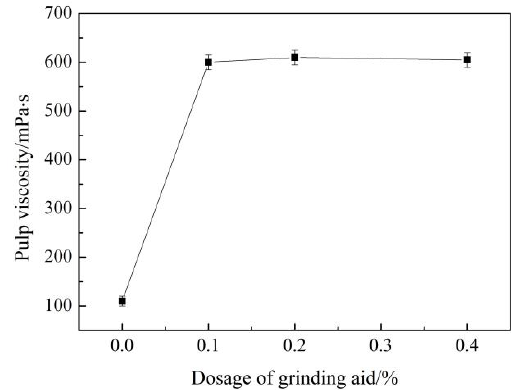
Figure 3. The relationship between pulp viscosity and grinding aid dosage.